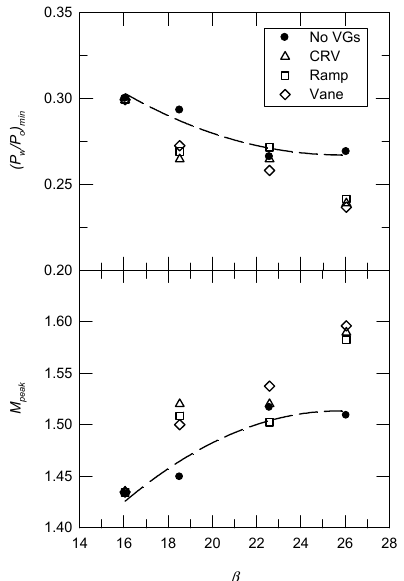
Figure 10. The effect of the presence of MVGs on flow expansion near the corner’s apex.